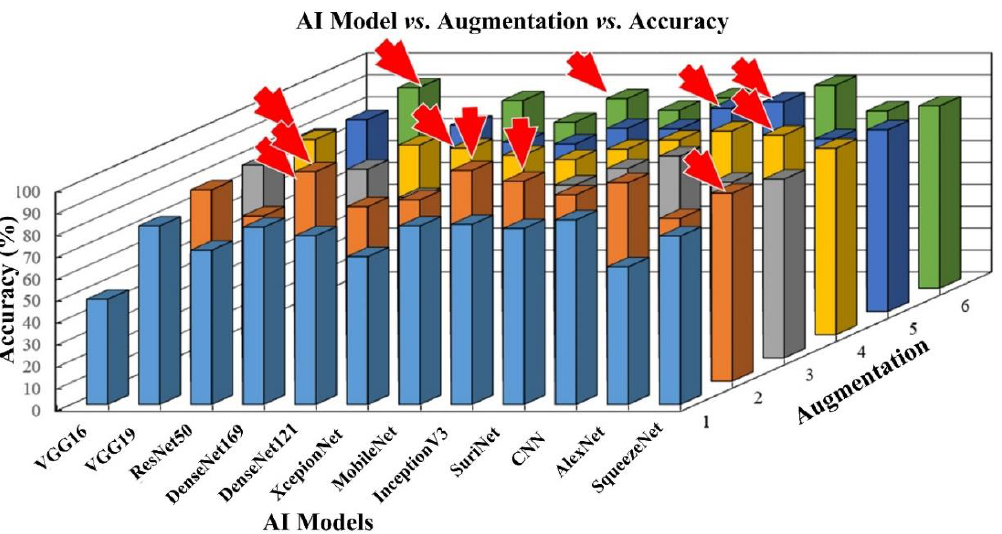
Figure 13. 3D bar chart representation of the AI model accuracy vs. augmentation folds, light blue color bar represents the Aug 1×, orange color bar represents the Aug 2×, gray color bar represents Aug 3×, yellow bar represents the Aug 4×, dark blue color represents Aug 5×, green color bar represents Aug 6×, and red arrow represents the optimization point of each classifier.